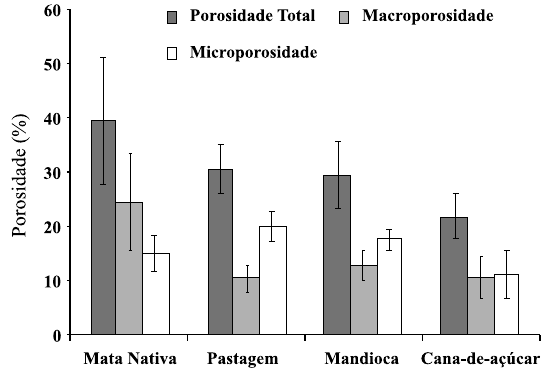
Figura 5. Valores de porosidade total, macro e microporosidade do solo em áreas de mata e áreas cultivadas com pasto, mandioca e cana- de-açúcar, na camada de 0 a 0,10 m. As barras indicam o intervalo de confiança (95 %). As médias são estatisticamente diferentes quando não ocorre sobreposição das